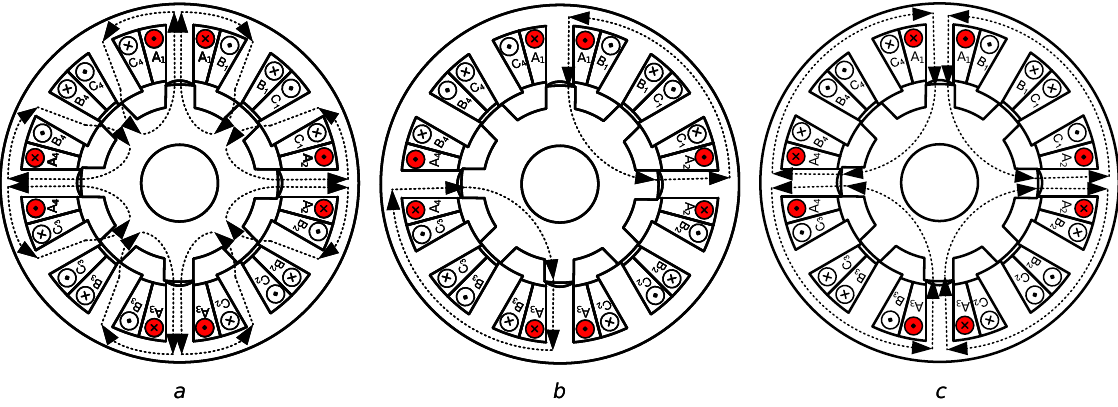
Figure 1. Winding arrangement for single-phase excitation; ( a ) Short-pitched winding 1; ( b ) Short- pitched winding 2; and ( c ) Short-pitched winding